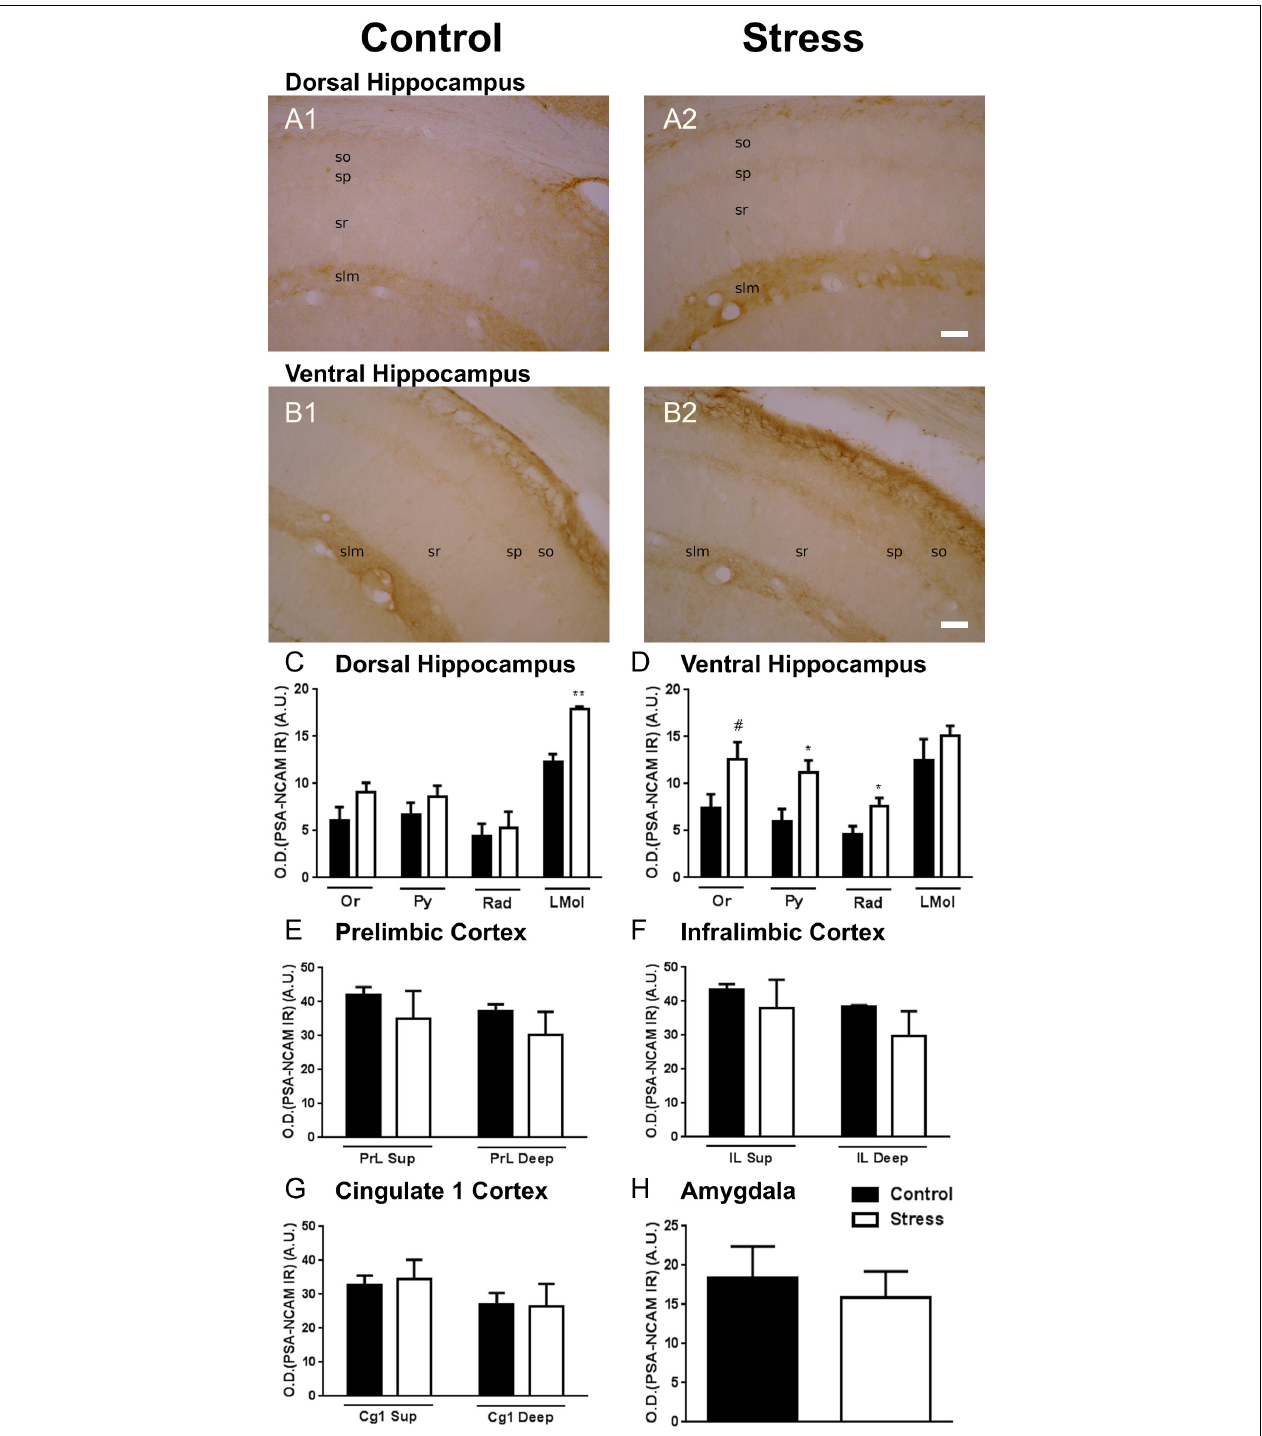
FIGURE 1 | Graphs representing the changes in the intensity of the polysialylated form of the neural cell adhesion molecule (PSA-NCAM) immunostaining in the neuropil of different telencephalic regions. (A,B) Microphotographs of the dorsal (A) and ventral (B) hippocampus of a control (A1,B1) and a chronically stressed (A2,B2) rat. (C,D) CA1 region of the dorsal (C) and ventral (D) hippocampus, including the strata oriens (Or), pyramidale (Py) radiatum (Rad) and lacunosum-moleculare (LMol). (E–G) superficial (I–III, Sup) and deep (IV–VI) layers of the mPFC, including the prelimbic (PrL, E ), infralimbic (IL, F ) and cingulate 1 (Cg1, G ) cortices. (H) Basolateral amygdala (BLA). Values represent mean ± S.E.M. Asterisks indicate statistically significant differences between groups (Control × Stress) after unpaired Student’s t -test ( ∗ p < 0.05; ∗∗ p < 0.01; # 0.1 < p < 0.05). Scale bars: 15 µ m.